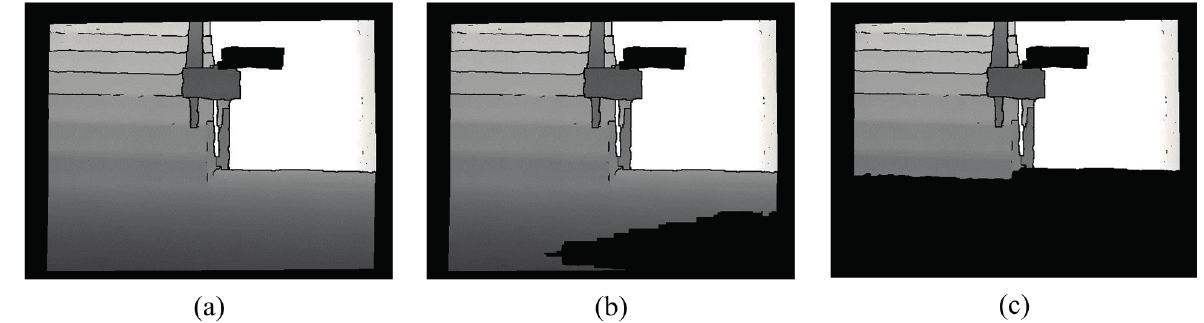
Figure 11. The result of the offset. ( a ) Original depth map; ( b ) Result image before offset; ( c ) Result image after offset.